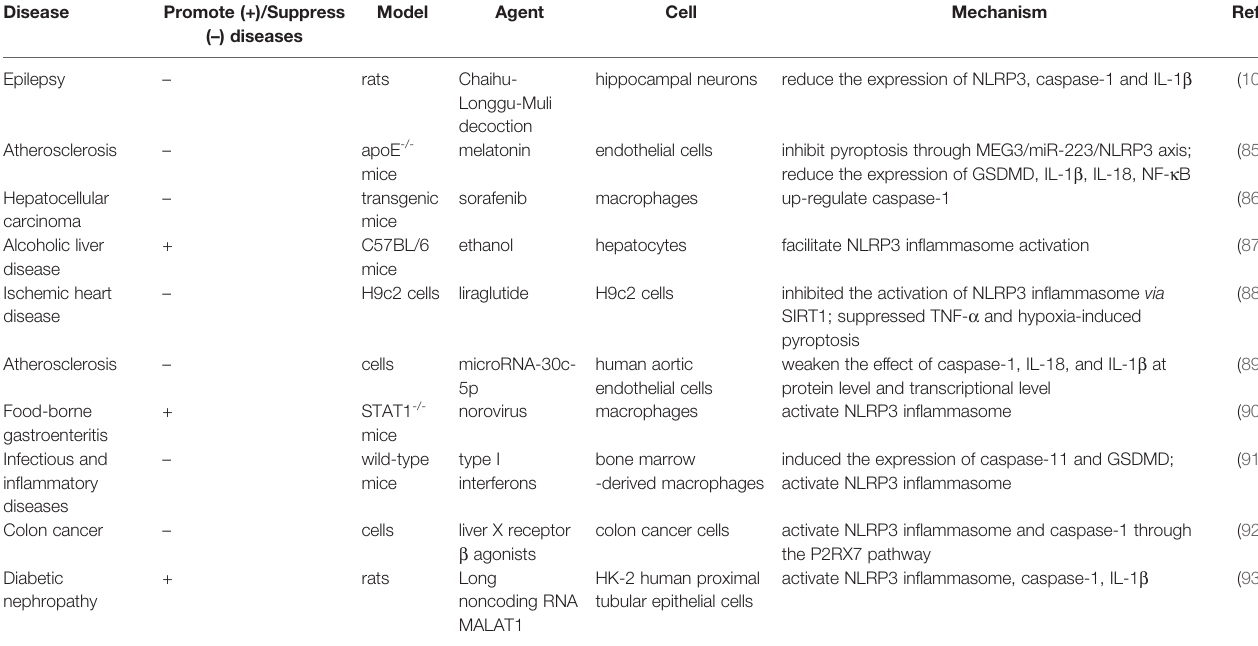
TABLE 6 | The role of pyroptosis in different diseases. Promote (+)/Suppress ( – )